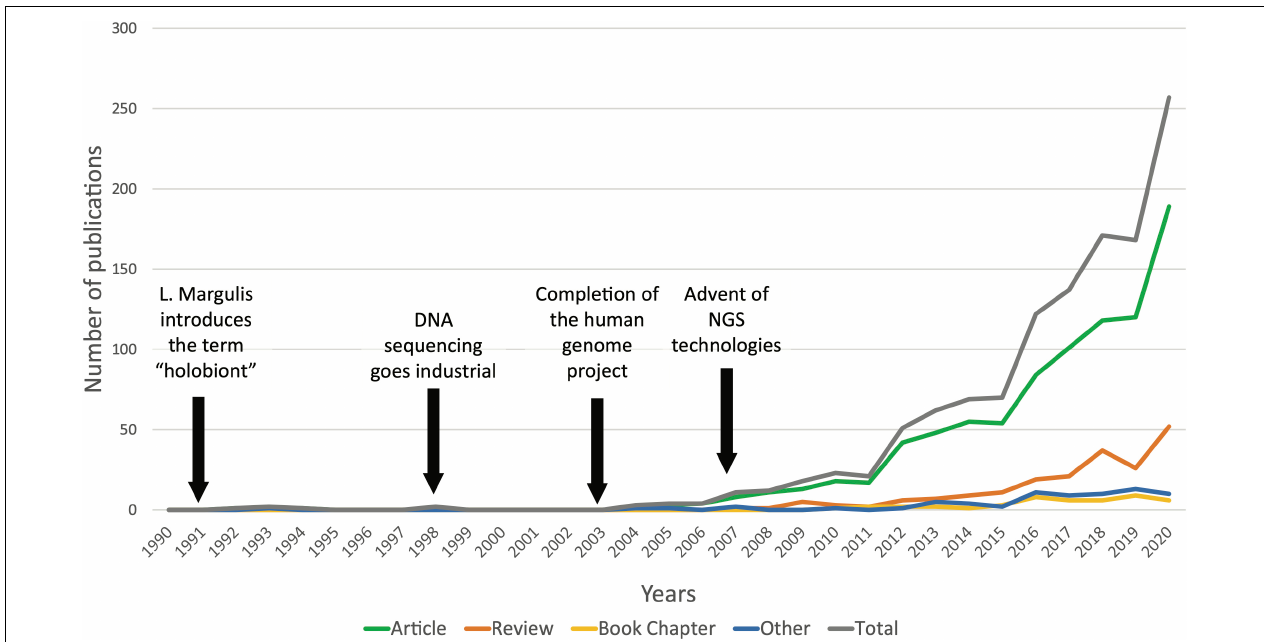
FIGURE 1 | Occurrence of the term “holobiont” in the title, abstract, and/or keywords of scientific publications from 1990 to December 2020 ( N = 1209). Data retrieved from the curated citation and abstract database